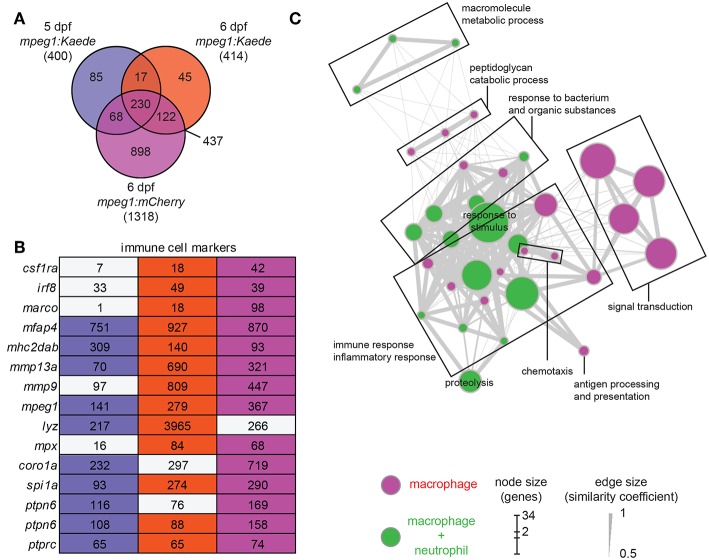
Core expression of macrophages in zebrafish larvae. (A) Overlap of the genes enriched (P-adj < 0.01) in zebrafish larval macrophages (zfM) at 5 or 6 dpf from mpeg1-driven Kaede and mCherry reporter fish. The zfM core expression is defined as the overlap of two or three mpeg1 positive populations and includes 437 genes. (B) Expression table of immune cell specific genes. First, second and third columns correspond, respectively, to macrophage expression from 5dpf mpeg1:Kaede, 6dpf mpeg1:Kaede, and 6dpf mpeg1:mCherry reporter larvae. Colored cells correspond to genes enriched in the corresponding sequencing data (log2 (fold change) > 1, P-adj < 0.01) whereas gray cells correspond to non-enriched genes. Numbers are expression levels expressed in TPM in fluorescence positive cells. (C) Network visualization of GO enrichment analysis of genes from the core macrophage expression data set using BiNGO and EnrichmentMap. Magenta nodes are terms found exclusively in the zfM core dataset and green nodes are found in both zfM core and neutrophil data sets. Node size corresponds to the number of genes associated to the enriched GO term and edge size to the similarity coefficient between two nodes.